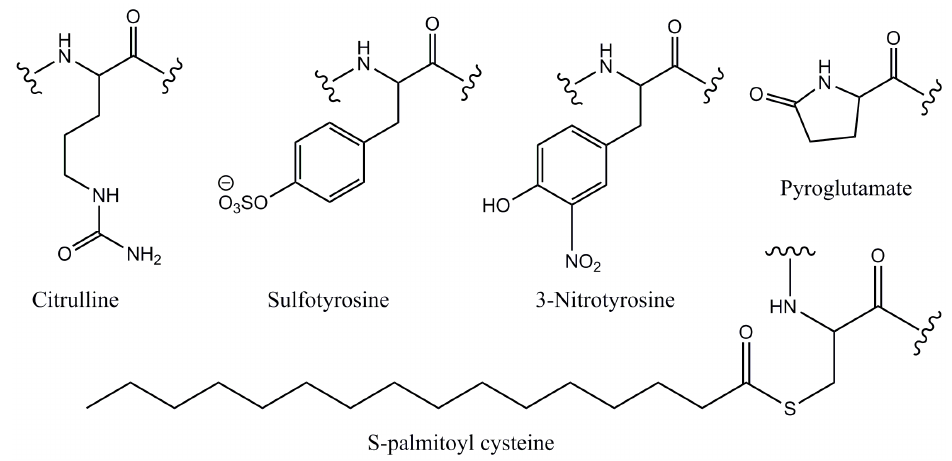
Figure 4. Examples of post-translationally modified amino acid residues found in chemokines and chemokine receptors.